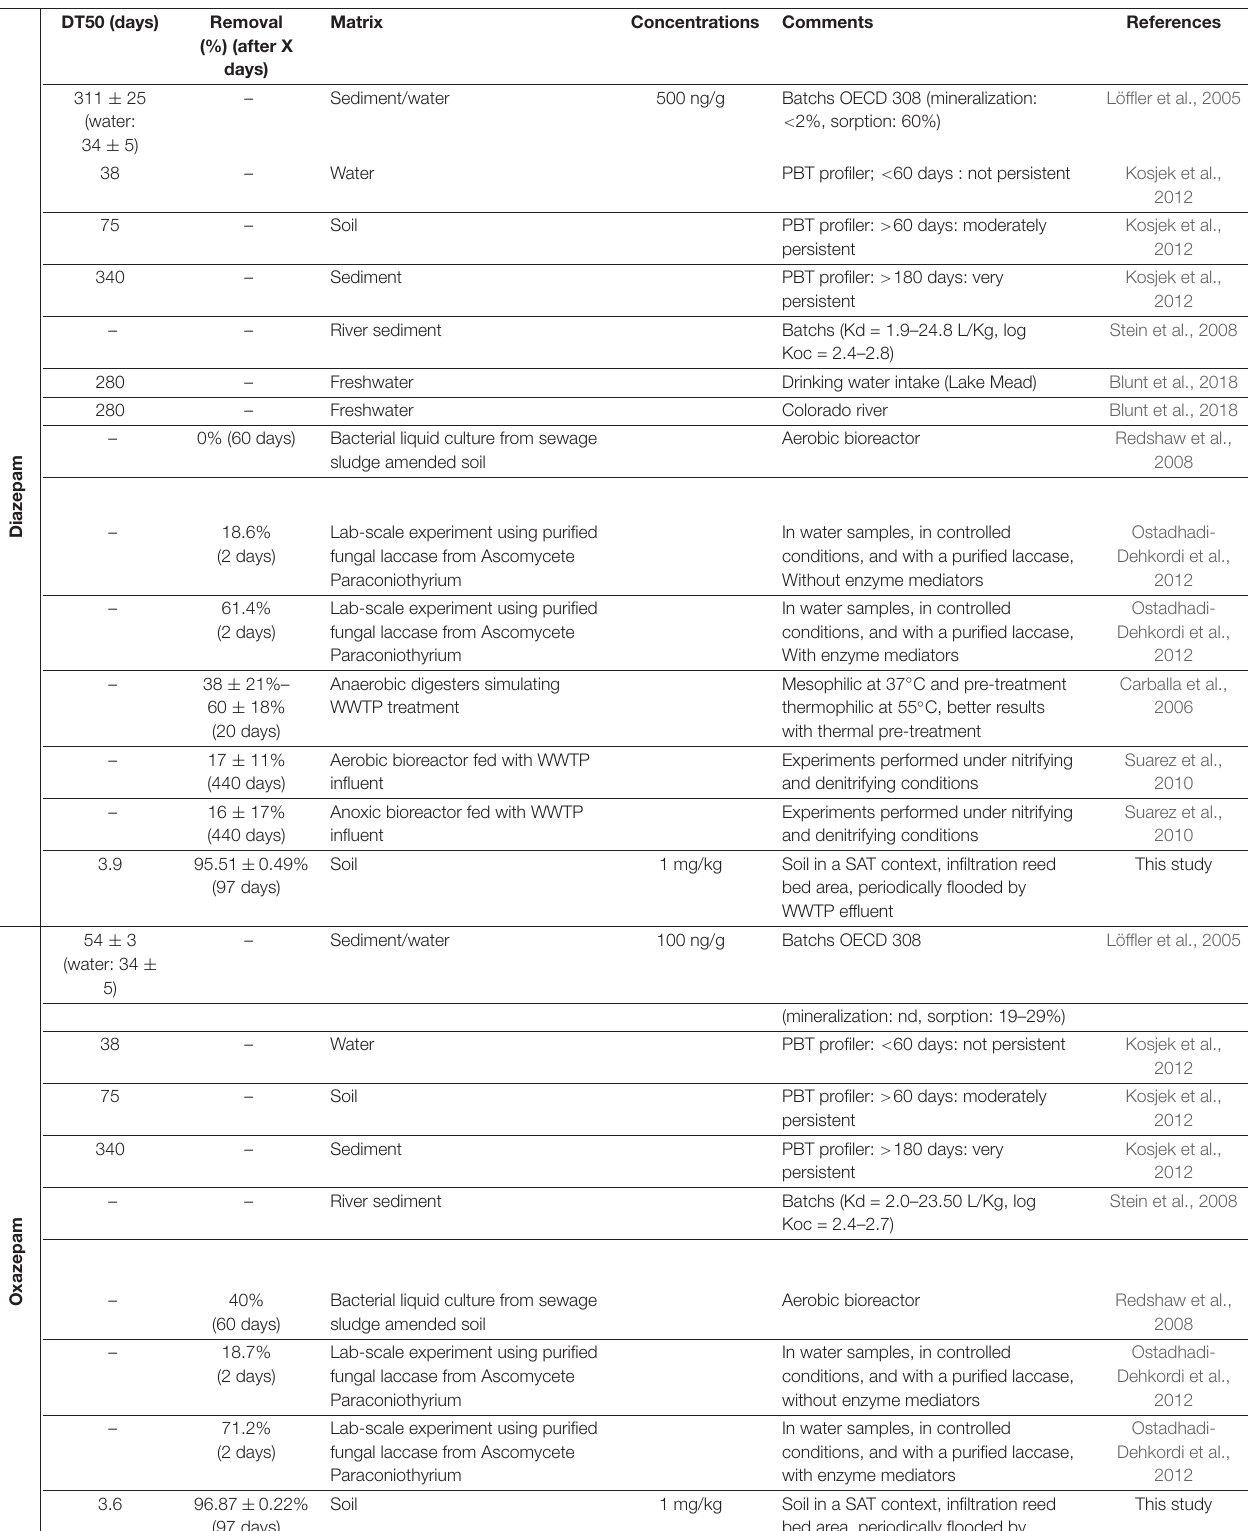
TABLE 1 | Generally described DZ and OXA biodegradation in environmental samples, cultures from environmental sample, or experimental biodegradation studies. DT50